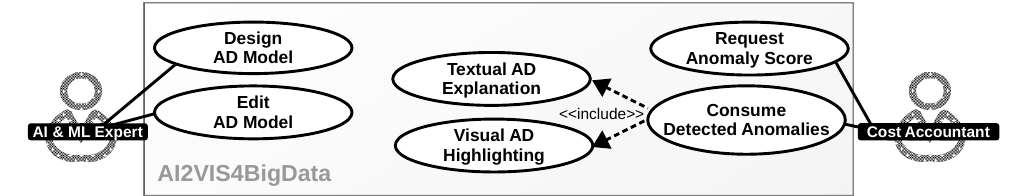
Figure 7. Anomaly detection use cases in an insurance company following the user